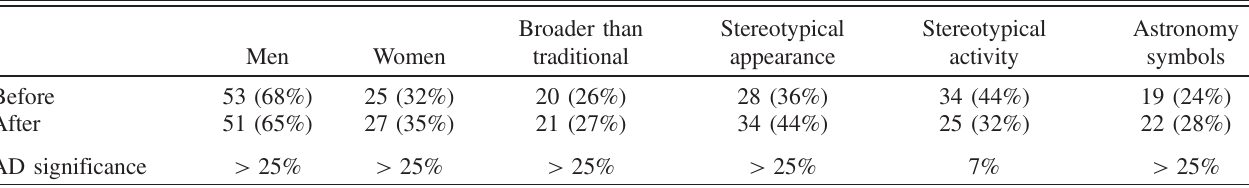
TABLE III. Before and after club statistics, presenting the number of before and after DASTs exhibiting each of the selected symbols (and the corresponding percentage in perentheses). The Anderson-Darling k -sample significance is given for each before-after pair, measuring the percent likelihood that the before and after measurements are drawn from the same population, with a cap of > 25% indicating which pairs of before and after samples are consistent with no